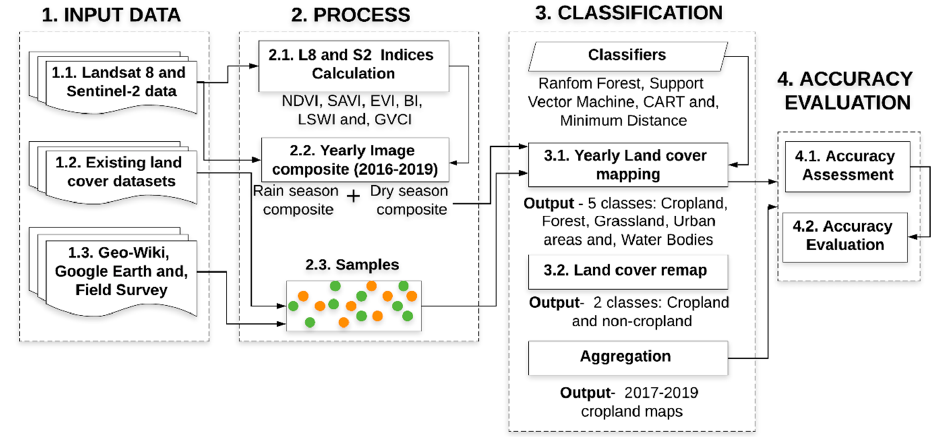
Figure 3. Distribution of the training (6727) samples and validation (4639) samples over the ZRB.